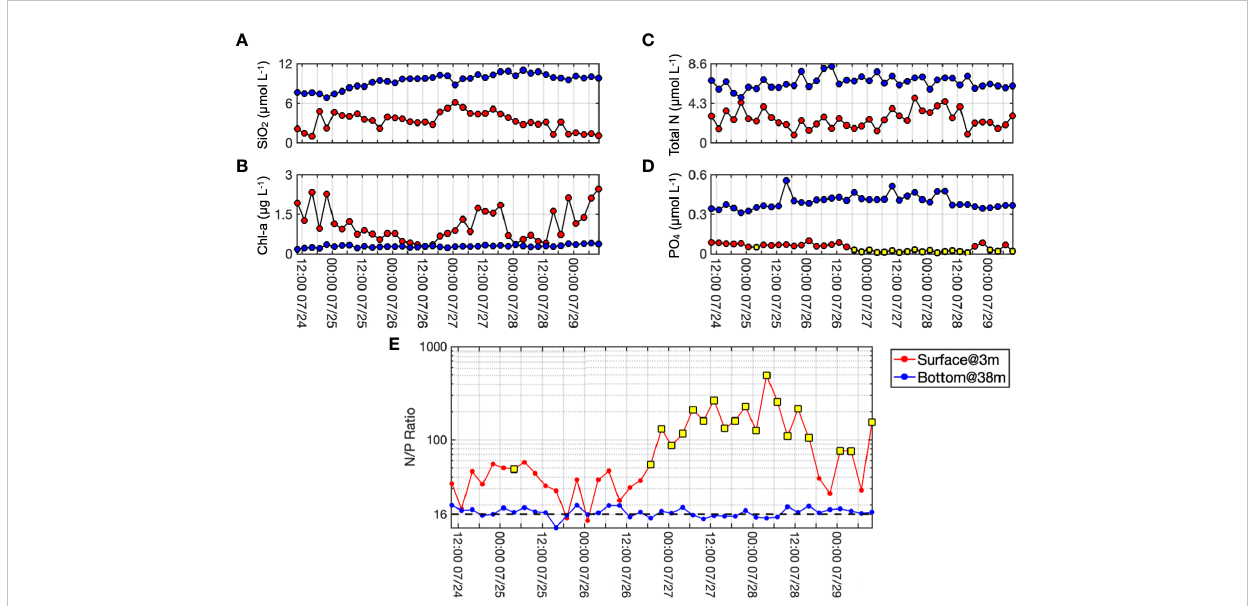
FIGURE 4 Temporal variabilities of (A) silicate, (B) Chl-a, (C) total N (nitrate + nitrite + ammonia), and (D) phosphate, and (E) the N/P ratio at the surface (red dots and line) and bottom (blue dots and line) at ZHJ2. The black dashed line in (E) indicates the Red fi eld ratio. The yellow squares marked data points of phosphate concentration below the detection